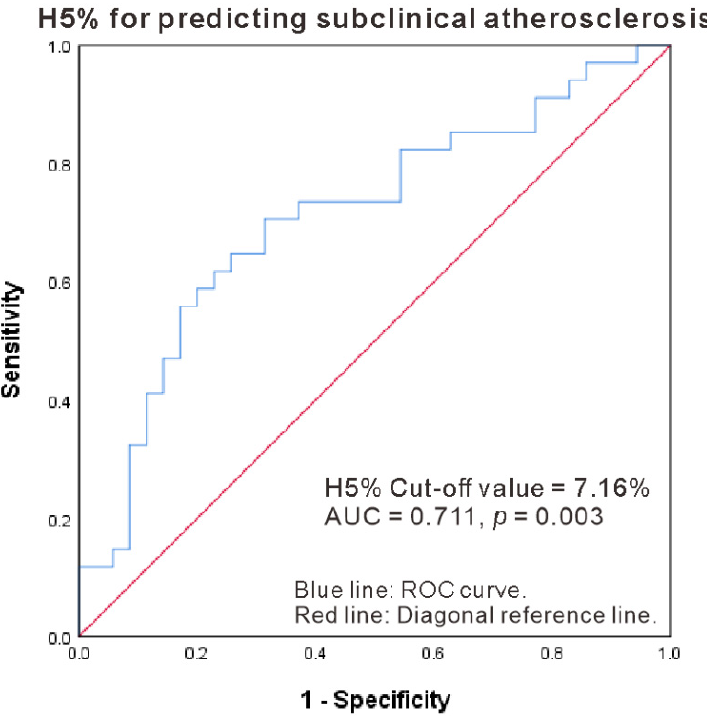
Figure 2. ROC curve analysis of plasma H5% for predicting the presence of subclinical atherosclerosis in RA patients. AUC: Area under ROC curve; Blue line: ROC curve; Red line: Diagonal refer- ence line.